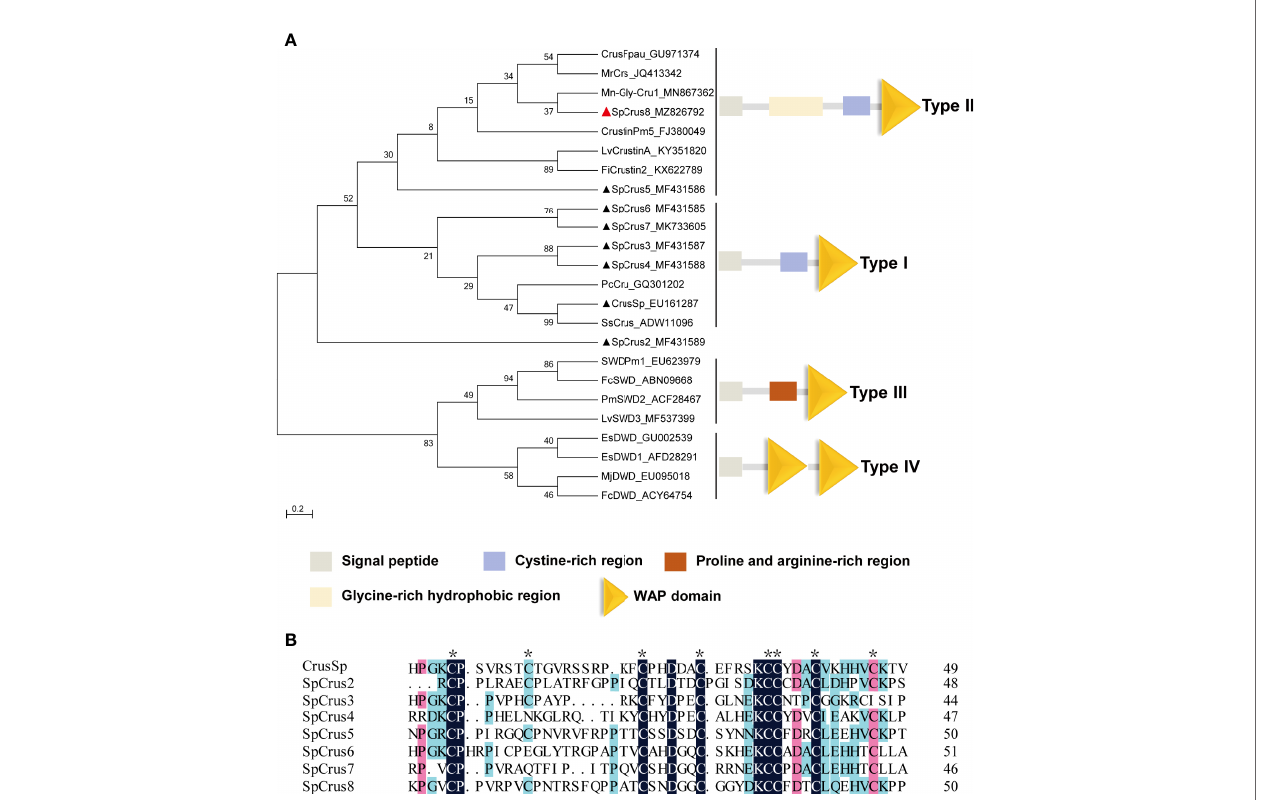
FIGURE 1 | Phylogenetic analysis of SpCrus8 and multiple sequence alignment of SpCrustins. (A) Phylogenetic tree analysis of SpCrus8. A neighbor-joining phylogenetic tree of crustins was constructed using MEGA ver.6.0 software with 3000 bootstrap replications. SpCrus8 is marked with a red triangle and other crustins of S. paramamosain are marked with black triangles. (B) Multiple sequence alignment of WAPD of crustins from S. paramamosain . Eight conserved cysteines involved in the formation of the disul fi de bridges in WAPD is indicated by “ * ” . Similar amino acids are shaded in red, light blue or dark blue. The information of the sequences is listed as follows: Mn: Macrobrachium nipponense ; Sp: Scylla paramamosain ; Lv: Litopenaeus vannamei ; Pm: Penaeus monodon ; Pj: Panulirus japonicus ; Fi: Fenneropenaeus indicus ; Mj: Marsupenaeus japonicus ; Fc: Fenneropenaeus chinensis ; Pc: Procambarus clarkii ; Ss: Scylla serrata . CrusSp (GenBank: EU161287), SpCrus2 (GenBank: MF431589), SpCrus3 (GenBank: MF431587), SpCrus4 (GenBank: MF431588), SpCrus5 (GenBank: MF431586), SpCrus6 (GenBank: MF431585), SpCrus7 (GenBank: